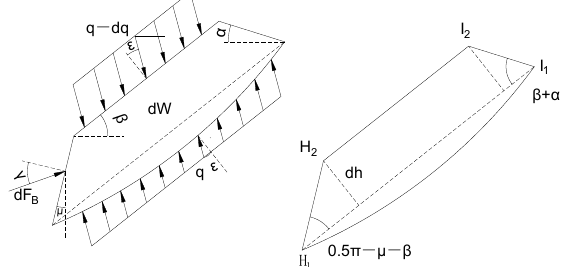
Figure 10. Physical diagram of grab dredger: 1—support cylinder; 2—turntable; 3—machine room; 4—load sensor; 5—balance system; 6—driver’s cab; 7—luffing mechanism; 8—boom system; 9— grab.